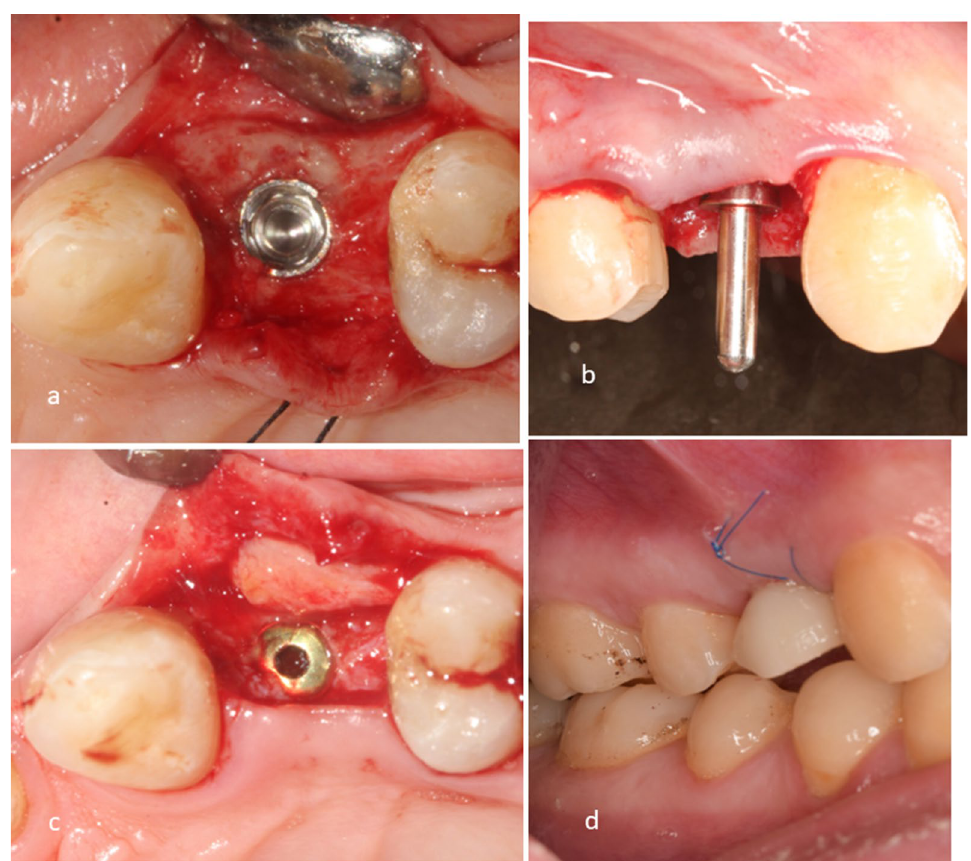
Fig. 1 Test group A : Implant Placement, B : Paralleling Pin, C : Connective tissue graft placement in the buccal pouch, D : PMMA temporary crown delivered 48 hrs after implant placement and put out of